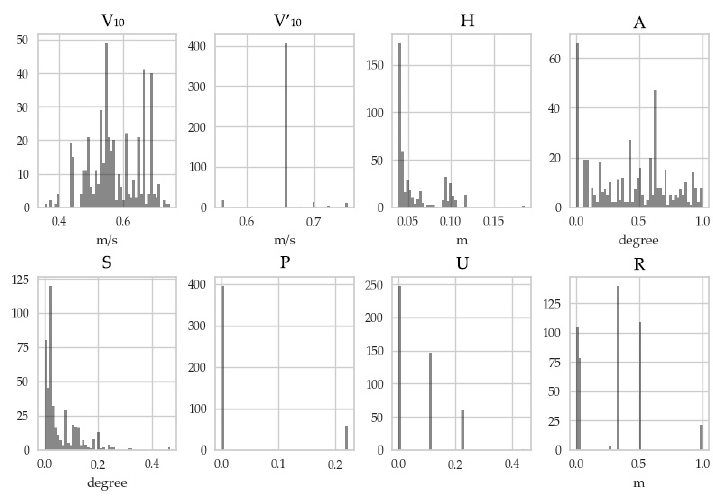
Figure 3. Distribution of the model side data.